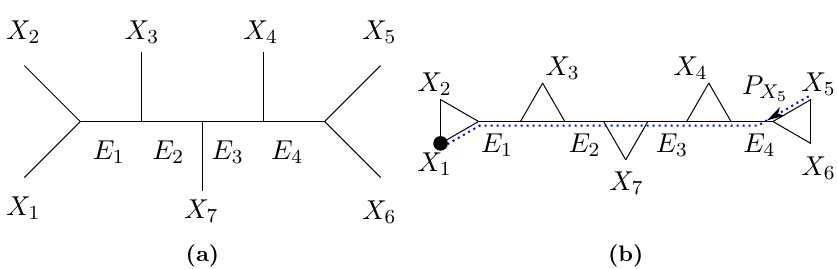
Figure 6. Figure 6a shows an n = 7 tree graph (cid:0); the external edges are labelled X i , i = 1 ; : : : ; 7 and the internal edges are labelled E j , j = 1 ; : : : ; 4. The blown-up graph b (cid:0) ((cid:12)gure 6b) has a base point at B = X 1 (indicated with a dot); a path P X dotted